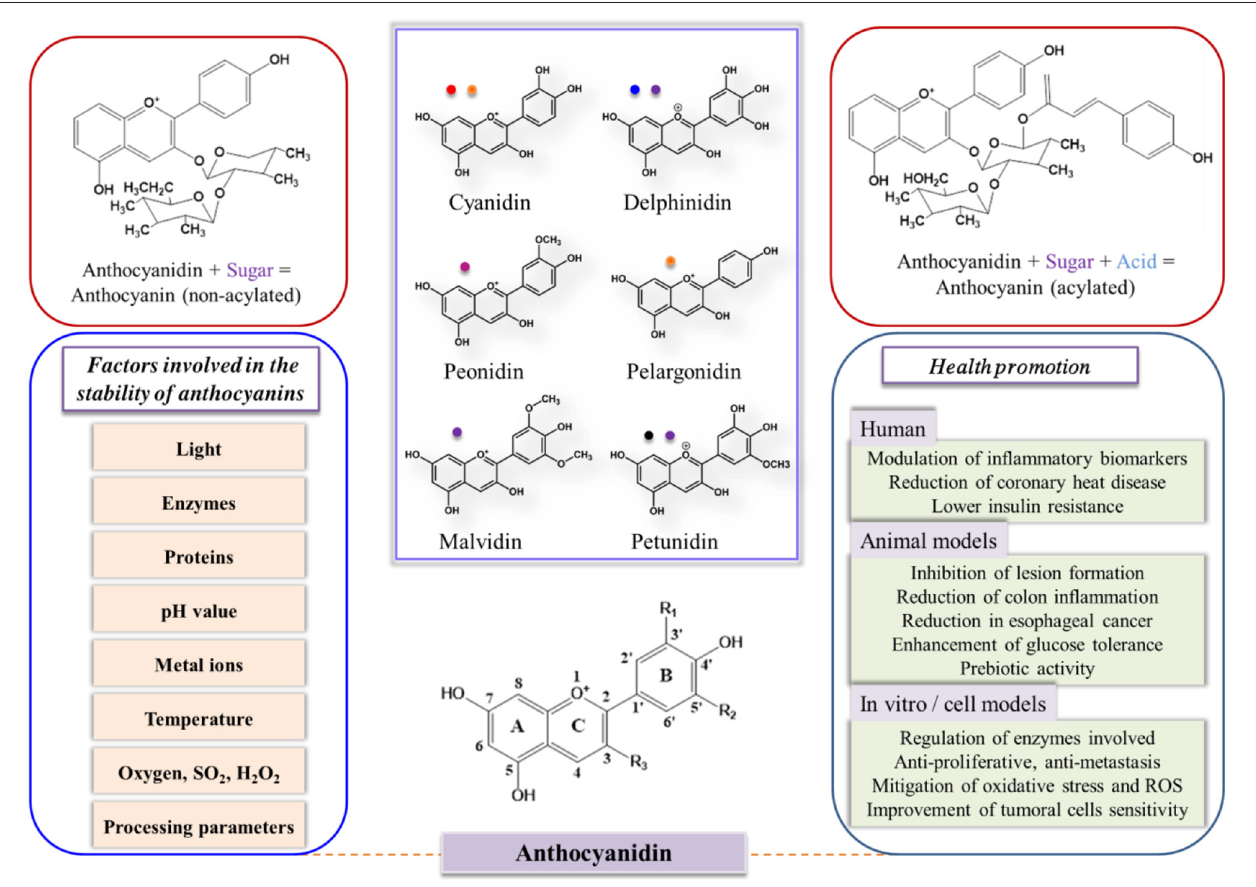
FIGURE 1 | Structures, main colors involved, and bioactivity of six important food anthocyanidins, as well as factors affecting the stability of anthocyanins. R 1 , R 2 = H or OH; R 3 = H or glucose. The parameters were adapted from (12, 21, 23–27) with permission.